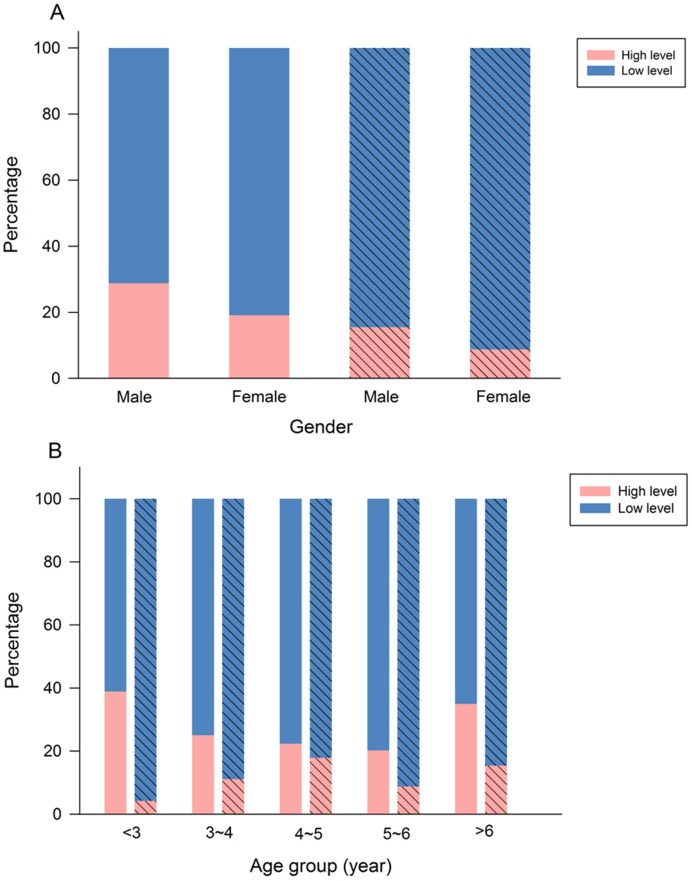
The percentage of children with high (≥10 µg/dL) and low (<10 µg/dL) blood lead levels in different sex (A) and age groups (B) in Guiyu and Haojiang.The bar with slash represents the Haojiang group.